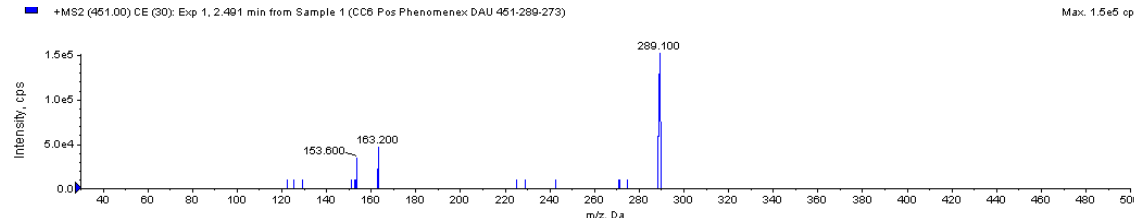
=2.49, potentially flavanomarein (ESI, positive). R